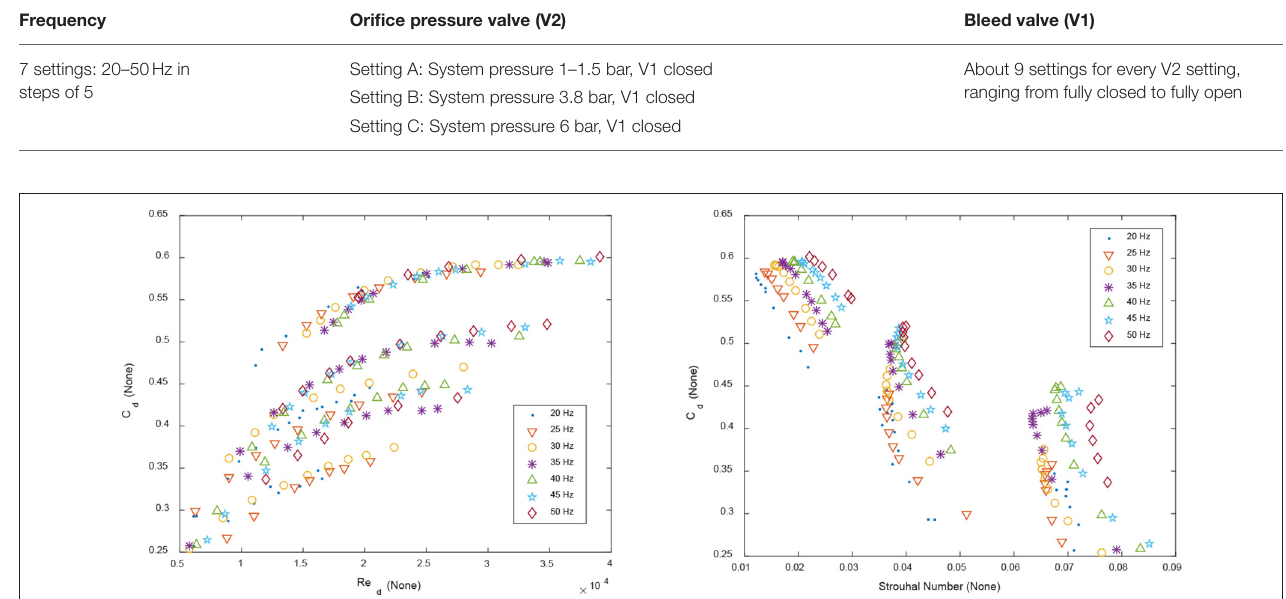
FIGURE 4 | Left: Discharge Coefficient C d calculated for the 189 data points generated by the pulsating flow apparatus as per the test plan shown by Table 1 . Orifice β 0.30. Right: Discharge Coefficient C d plotted against the Strouhal Number defined for an orifice by Equation (5). = (right) shows C d plotted against the Strouhal number, commonly used to characterize pulsating flows. The Strouhal St number